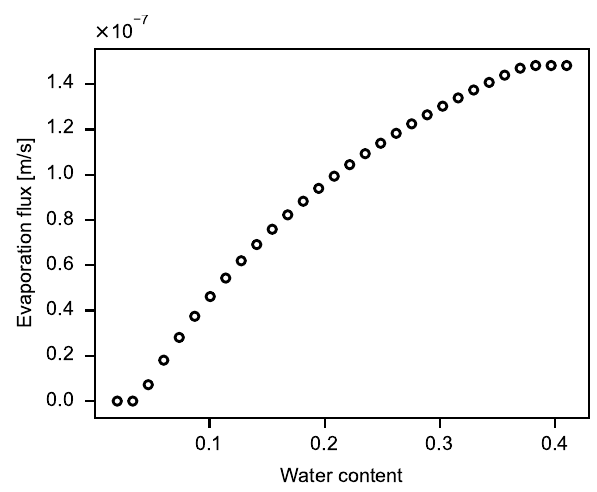
Figure 2. Evaporation rate ( q e ) as a function of water content with cutoff at residual content θ r =